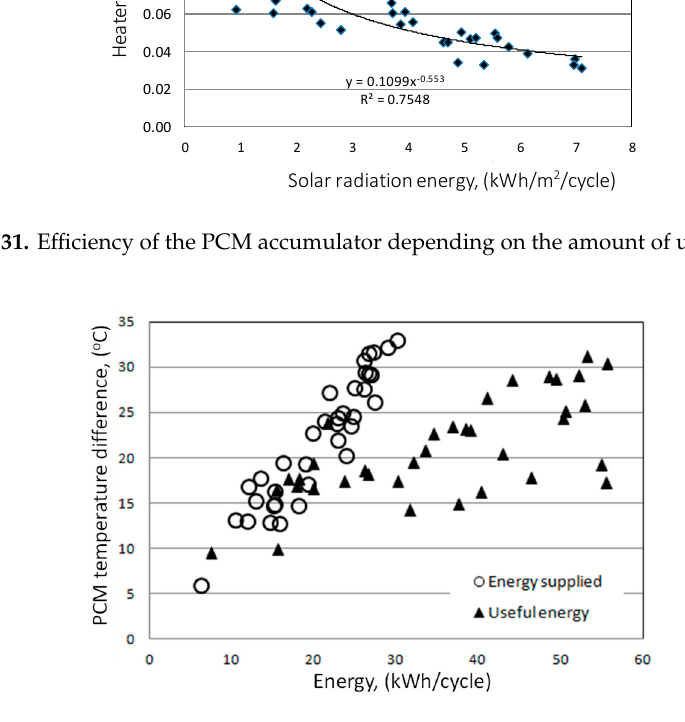
Figure 32. Difference in paraffin temperature as a function of supplied and usable energy of the PCM accumulator.